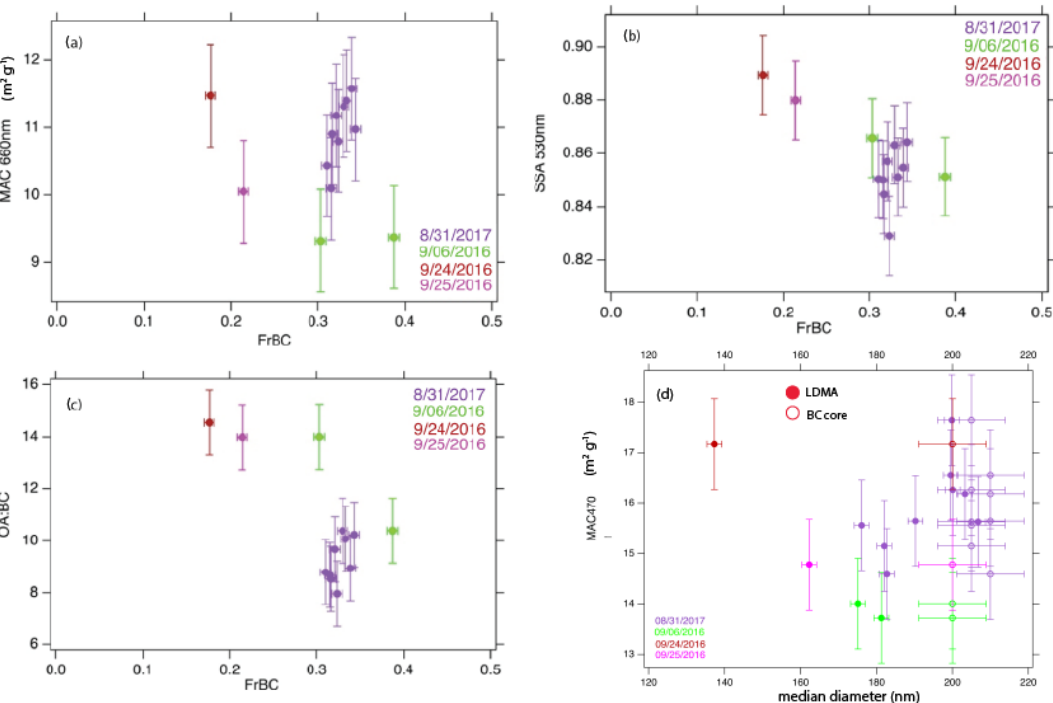
Figure 9. (a) Mass absorption coefficient (MAC BC , 660 ; units of m 2 g − 1 ) at 660nm wavelength versus the fraction of black-carbon- containing particles (FrBC), colored by flight day. Panel (b) is the same as (a) but for SSA 530 versus FrBC. Panel (c) is the same as (a) but for OA : BC mass versus FrBC. (d) MAC BC + OA , 470 (m 2 g − 1 ) versus LDMA median and mass median BC core diameter. All for the level legs listed in Table S2.